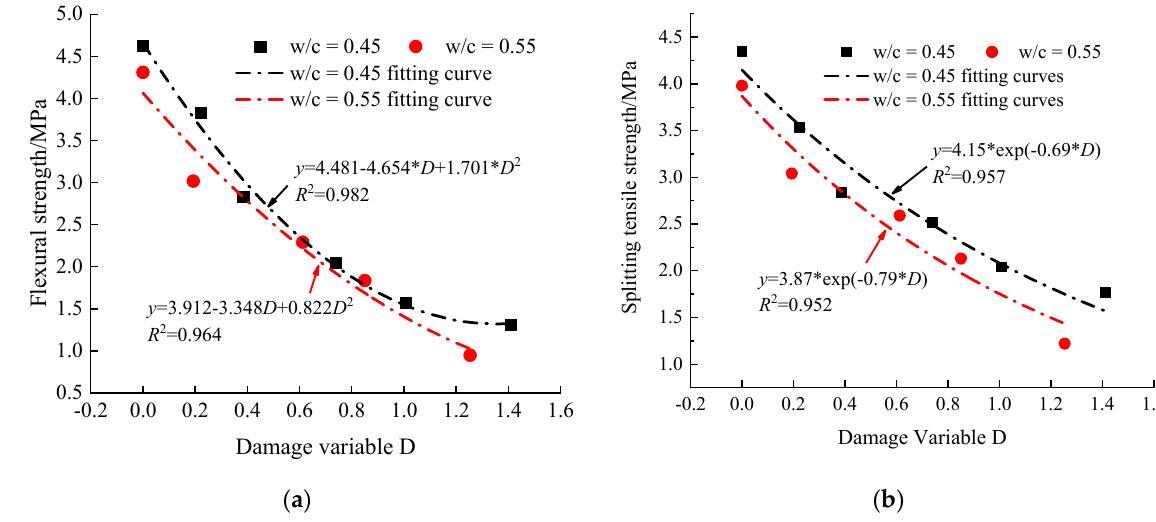
Figure 21. Relationship between mechanical properties of concrete specimens with different w/c ratio and damage variable. ( a ) Flexural strength and damage variable; ( b ) splitting tensile strength and damage variable.